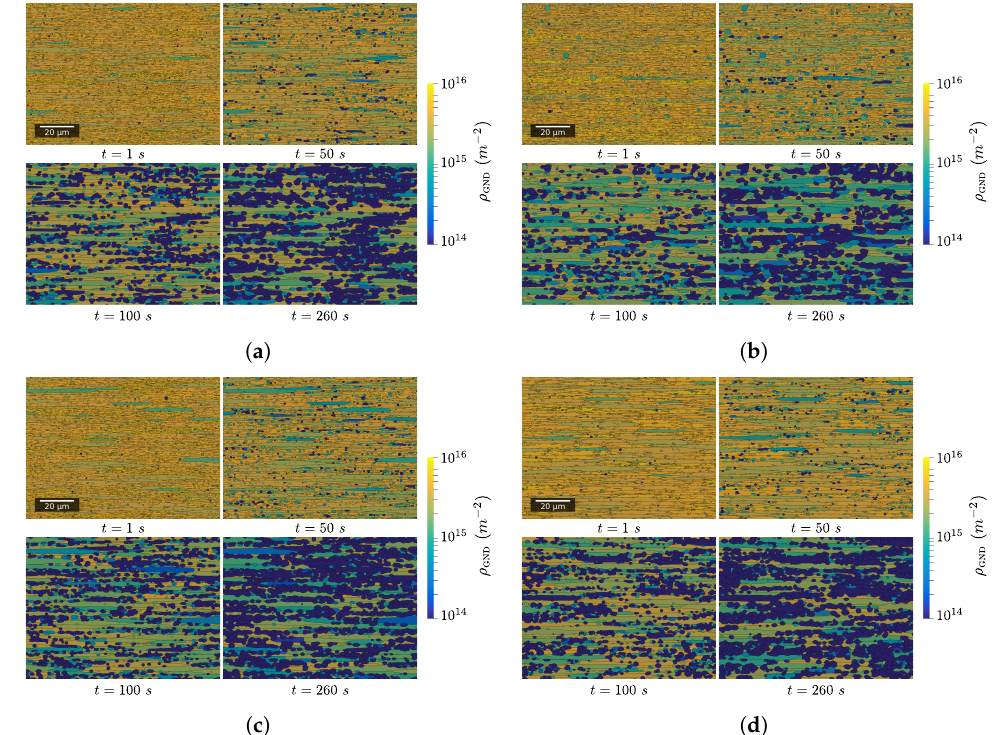
Figure 11. Evolution of digital microstructures with time for the four different test cases. ( a ) Local nucleation— γ h . ( b ) Global nucleation— γ h . ( c ) Local nucleation— γ h , M h . ( d ) Local nucleation— = γ h , d GB NewLAGB